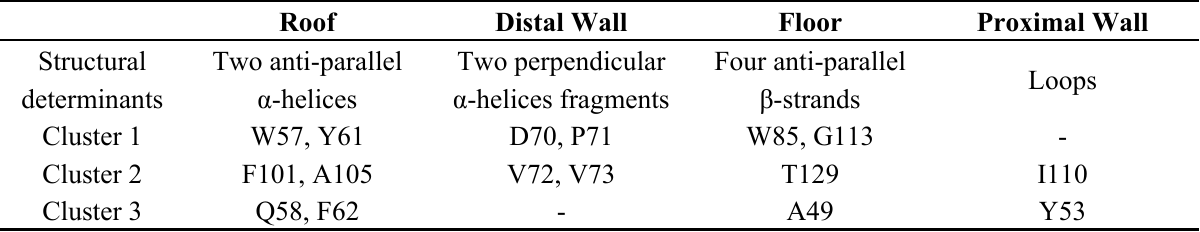
Table 2. Clusters three-dimensional spatial distribution in the ligand-binding site of the regulatory domain of the QS